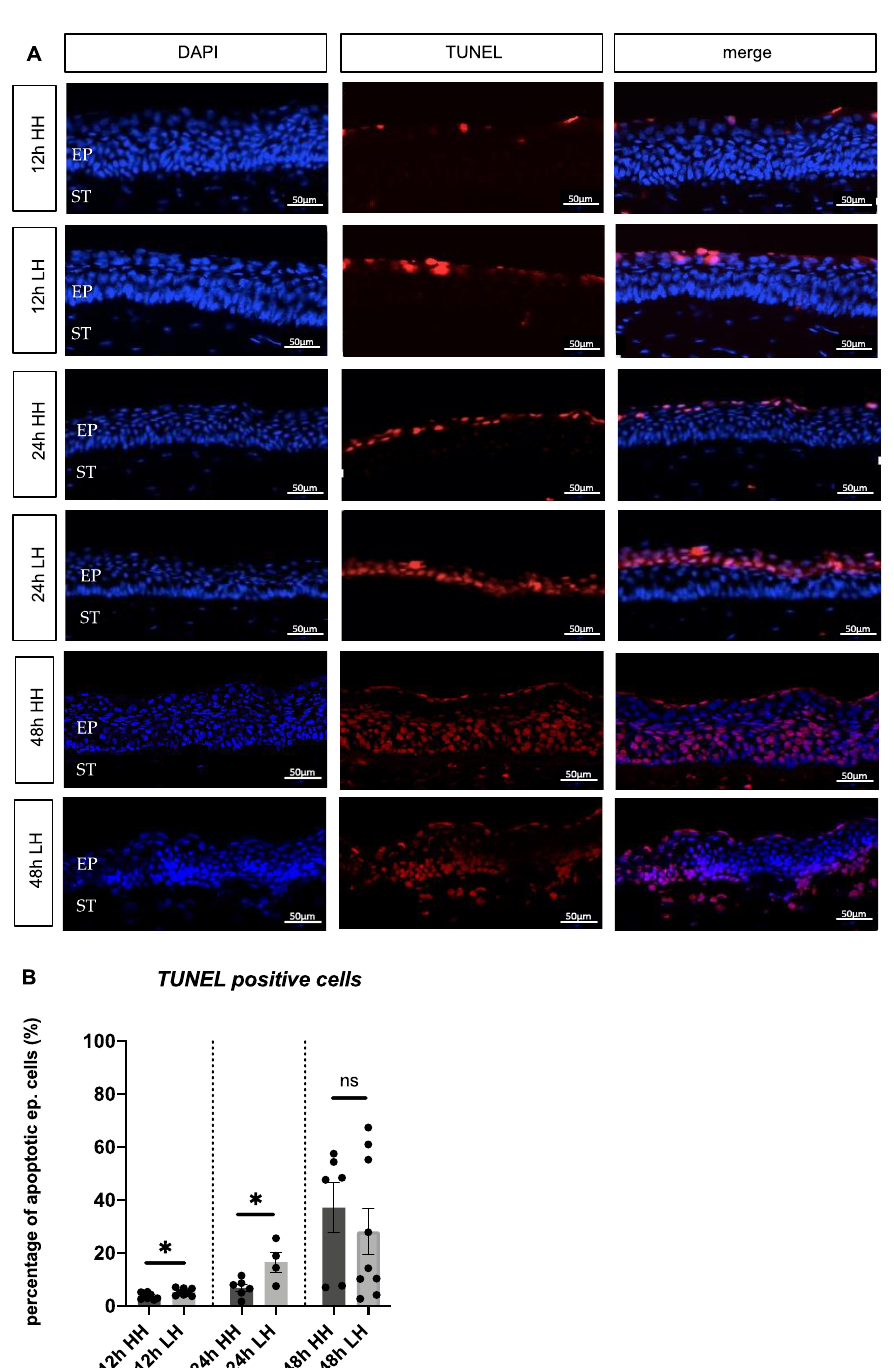
Figure 4. Incubation for 12 h and for 24 h at LH induced apoptosis in the corneal epithelium. ( A ) Representative images of porcine corneas incubated at LH for 12 h, 24 h and for 48 h and stained